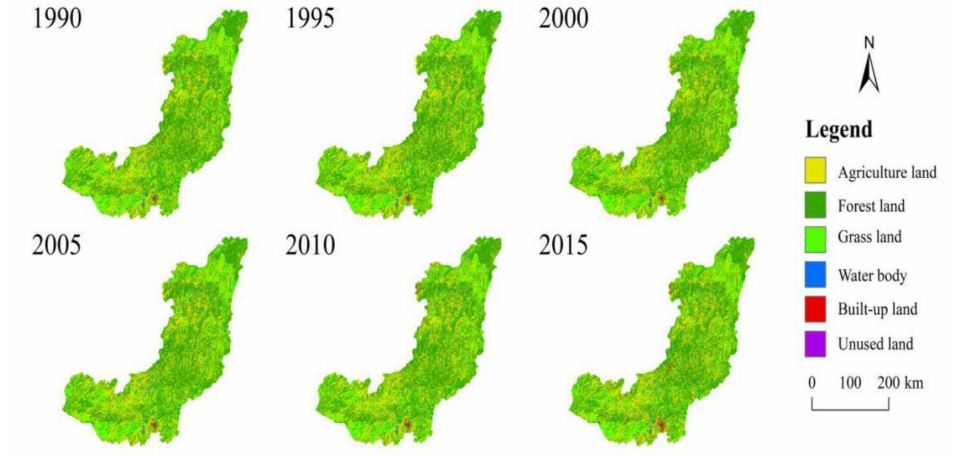
Figure 9. Spatial distribution of land-use in Wujiang River Basin in 1990, 1995, 2000, 2005, 2010, 2015. Table 7. Change in land-use area in different years in the Wujiang River Basin. Land-Use Pattern (km 2 )